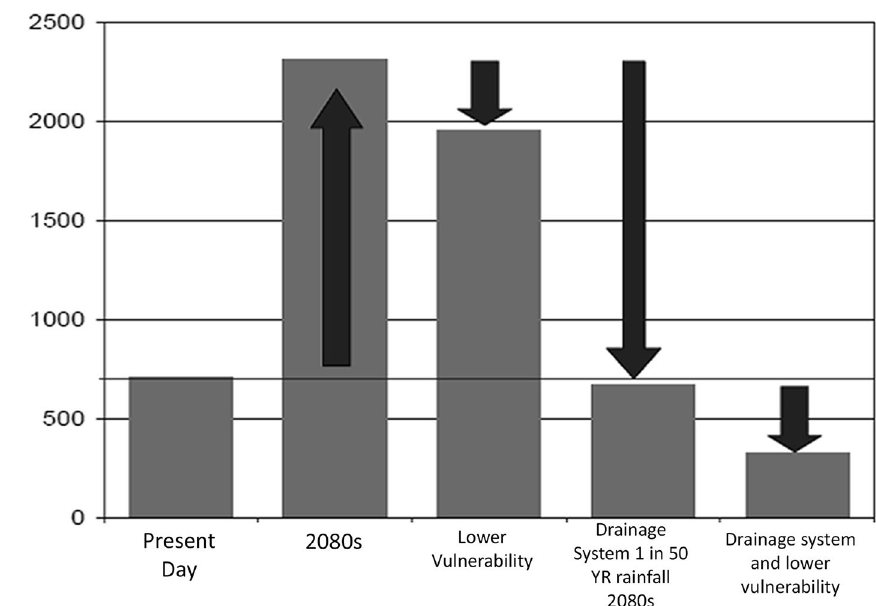
Fig. 2 Estimated total losses